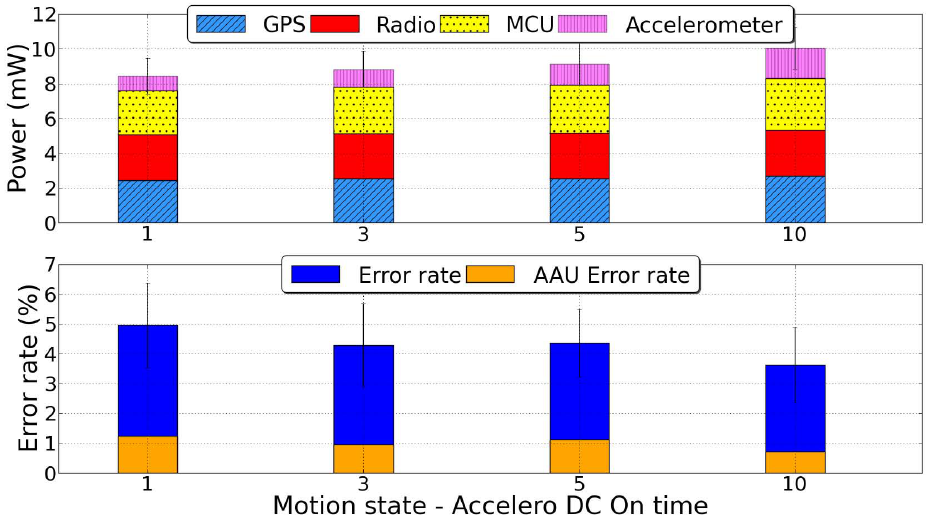
Figure 13. The effect of varying the accelerometer check time D S yields more accurate results as it reduces the effects of